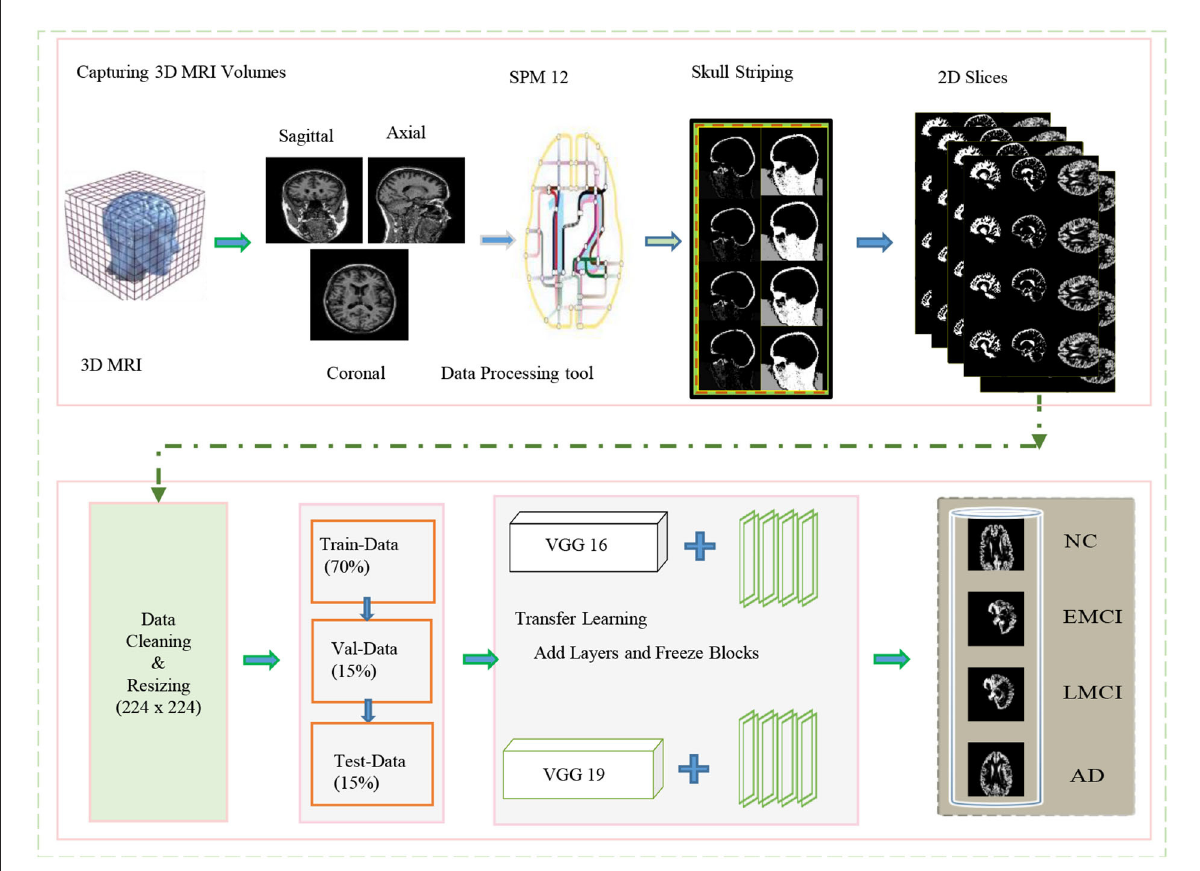
FIGURE1 Overview of the proposed framework for processing data and training in the network for